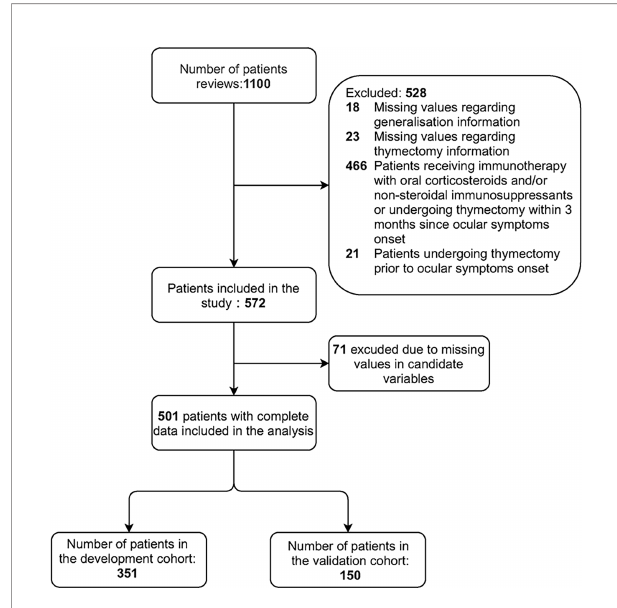
FIGURE 1 | Flowchart of participants included in the